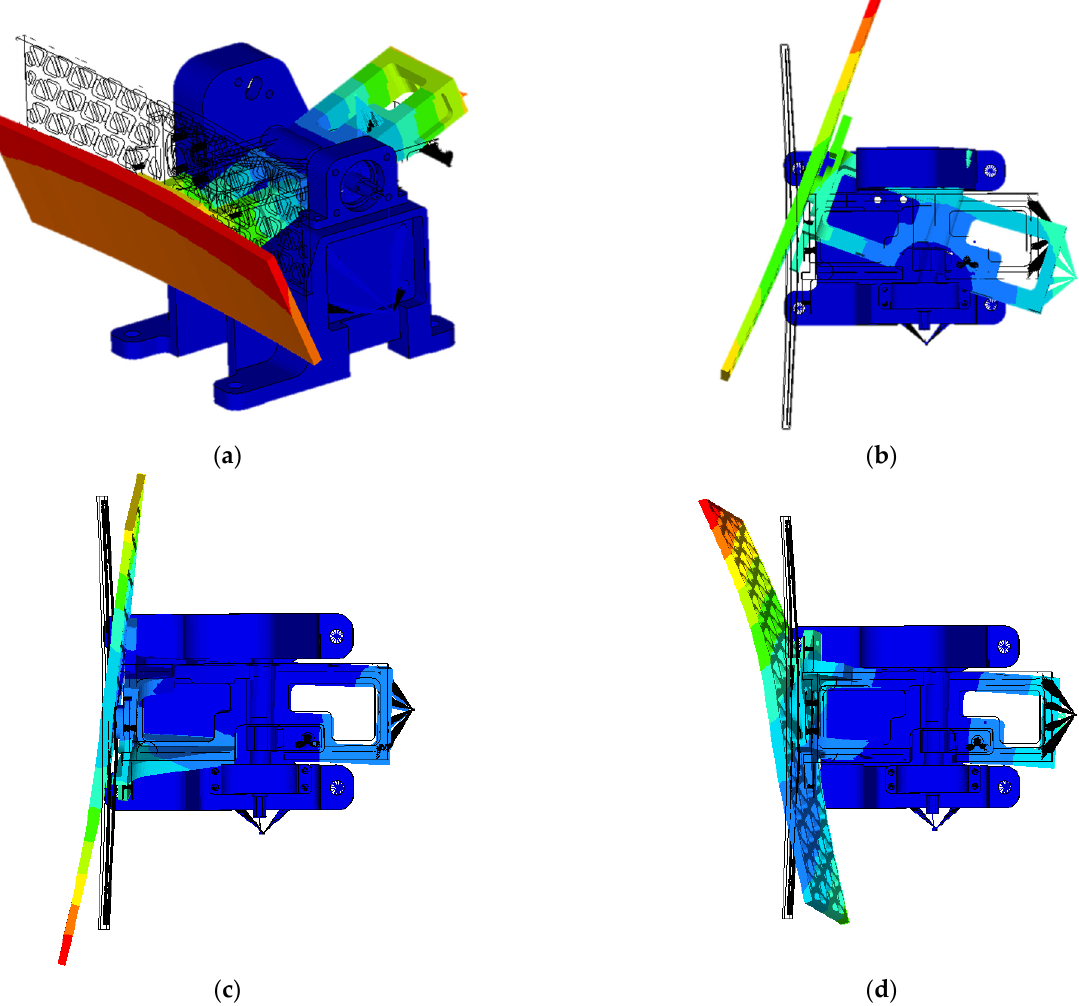
Figure 5. Mode shape of modal analysis results ( a ) 1st mode (17.3 Hz), ( b ) 2nd mode (92.4 Hz), ( c ) 3rd mode (158.6 Hz), ( d ) 4th mode (240.8 Hz).